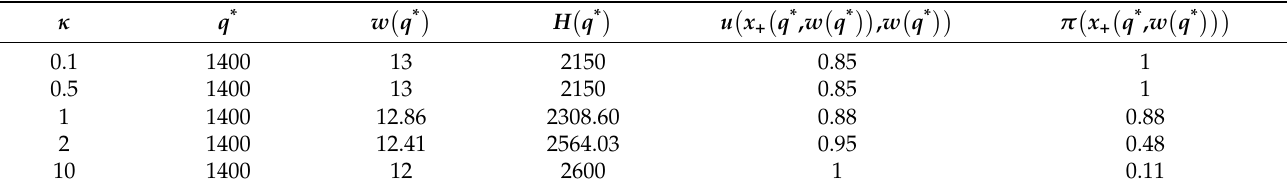
Table 5. Solutions of the proposed model with ϕ = 10